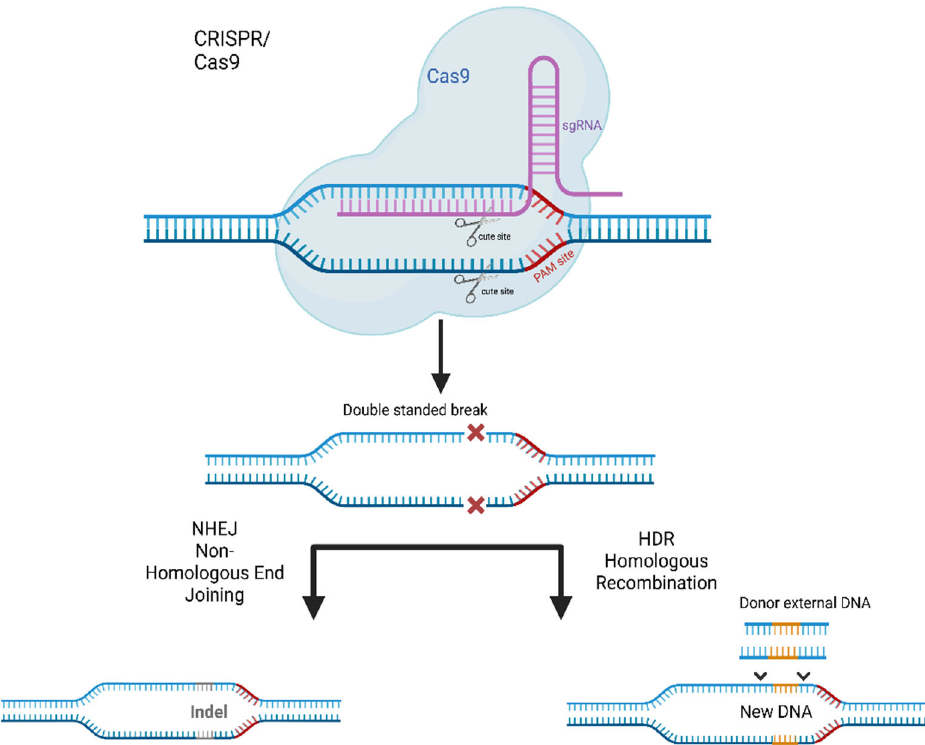
Figure 3. Techniques of CRISPR ‐ Cas9 genome editing system.